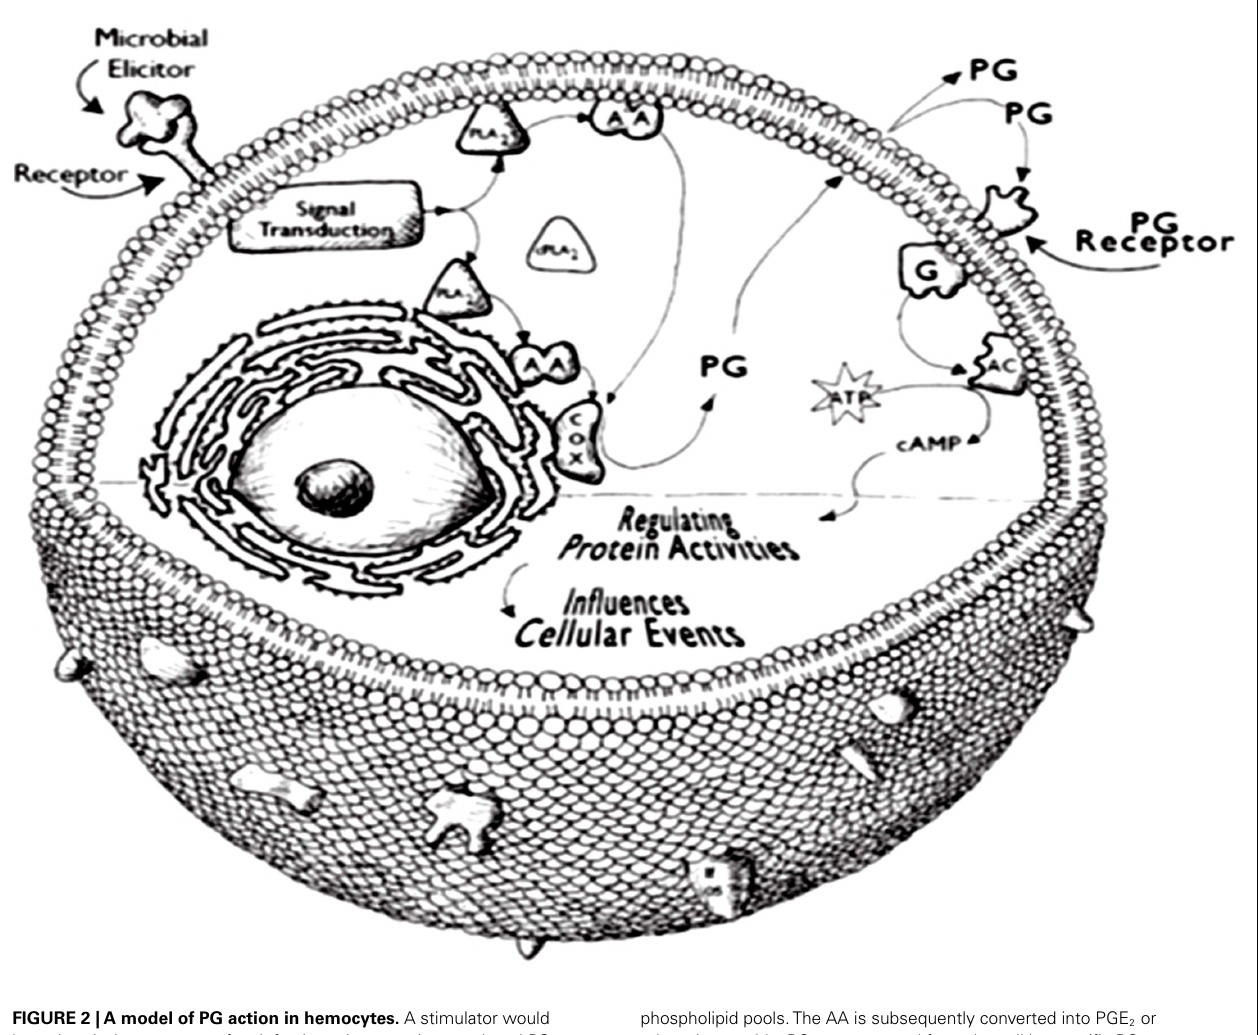
phospholipid pools.The AA is subsequently converted into PGE 2 or other eicosanoids. PGs are exported from the cell by specific PG transporter proteins.The PGs can interact with receptors located on the exporting cell (autocrine action) or with receptors located on other cells (paracrine